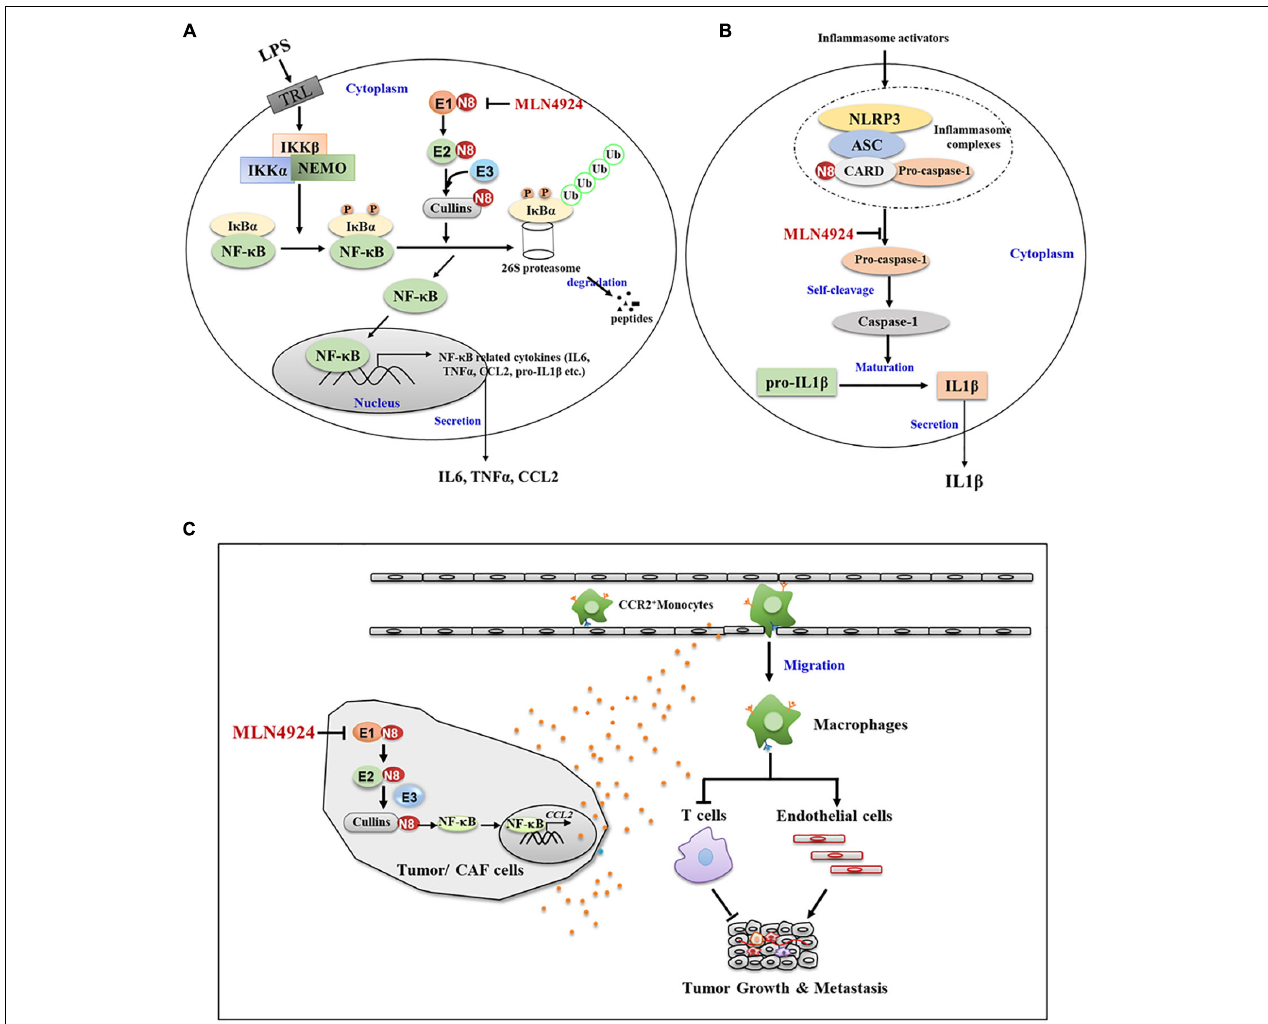
FIGURE 3 | Neddylation regulates the function and migration of macrophages. (A) Neddylation inactivation by MLN4924 inhibits the activity of CRLs and induces the accumulation of its substrate IKB α , which sequesters NF- K B in the cytoplasm to block NF- K B transcriptional activity. (B) MLN4924 inhibits neddylation modification of caspase-1 CARD domain, and thus diminishes caspase-1 maturation and reduces IL-1 β maturation and secretion. (C) Inactivation neddylation in tumor or CAF cells inhibited CCL2 expression and macrophage infiltration, thus mediating its lung metastasis-inhibitory